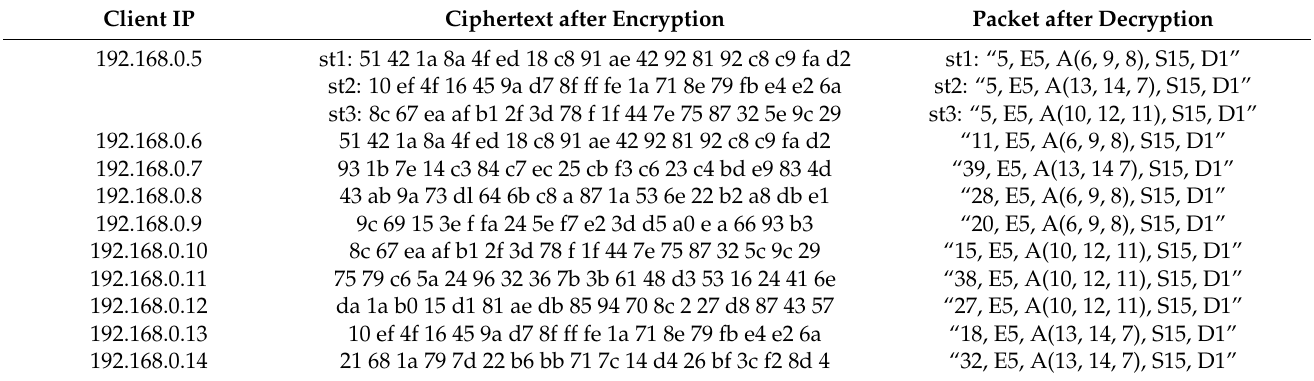
Table 2. Results of encryption and decryption through experiment (value of octet 4 for client 5–14).